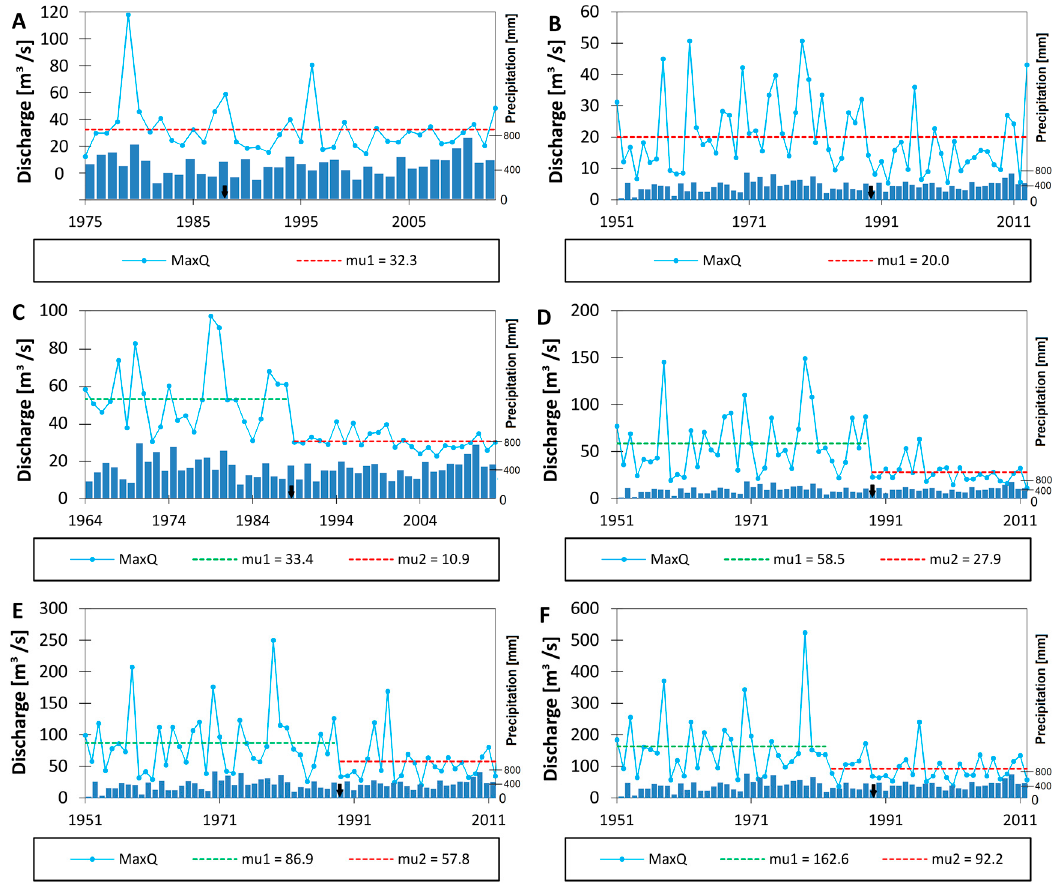
Figure 7. Annual maximum discharge for selected gauge stations of the Upper Narew Catchment: ( A ) Fasty, ( B ) Narewka, ( C ) Bondary, ( D ) Narew, ( E ) Sura ż , and ( F ) Str ę kowa Góra. “mu” stands for the average value of each time period. The black arrow indicates the year the SR started operation.